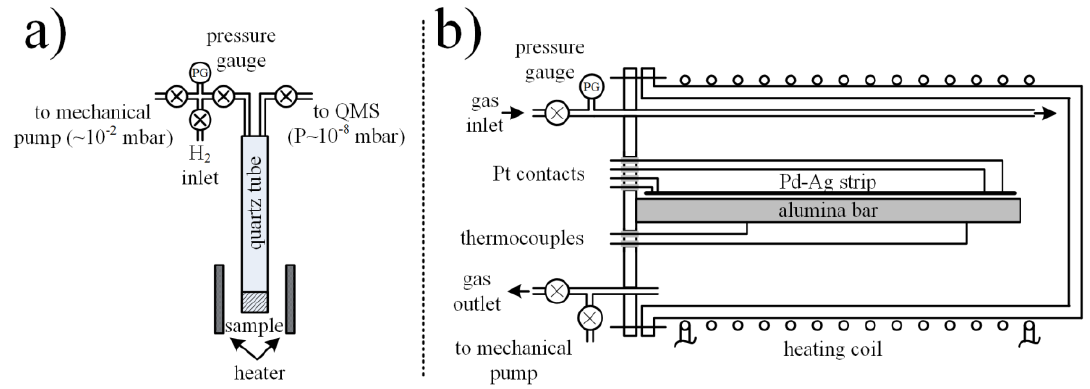
Figure 1. The schematic representation of ( a ) temperature-programmed desorption and ( b ) resistivity experimental setups.